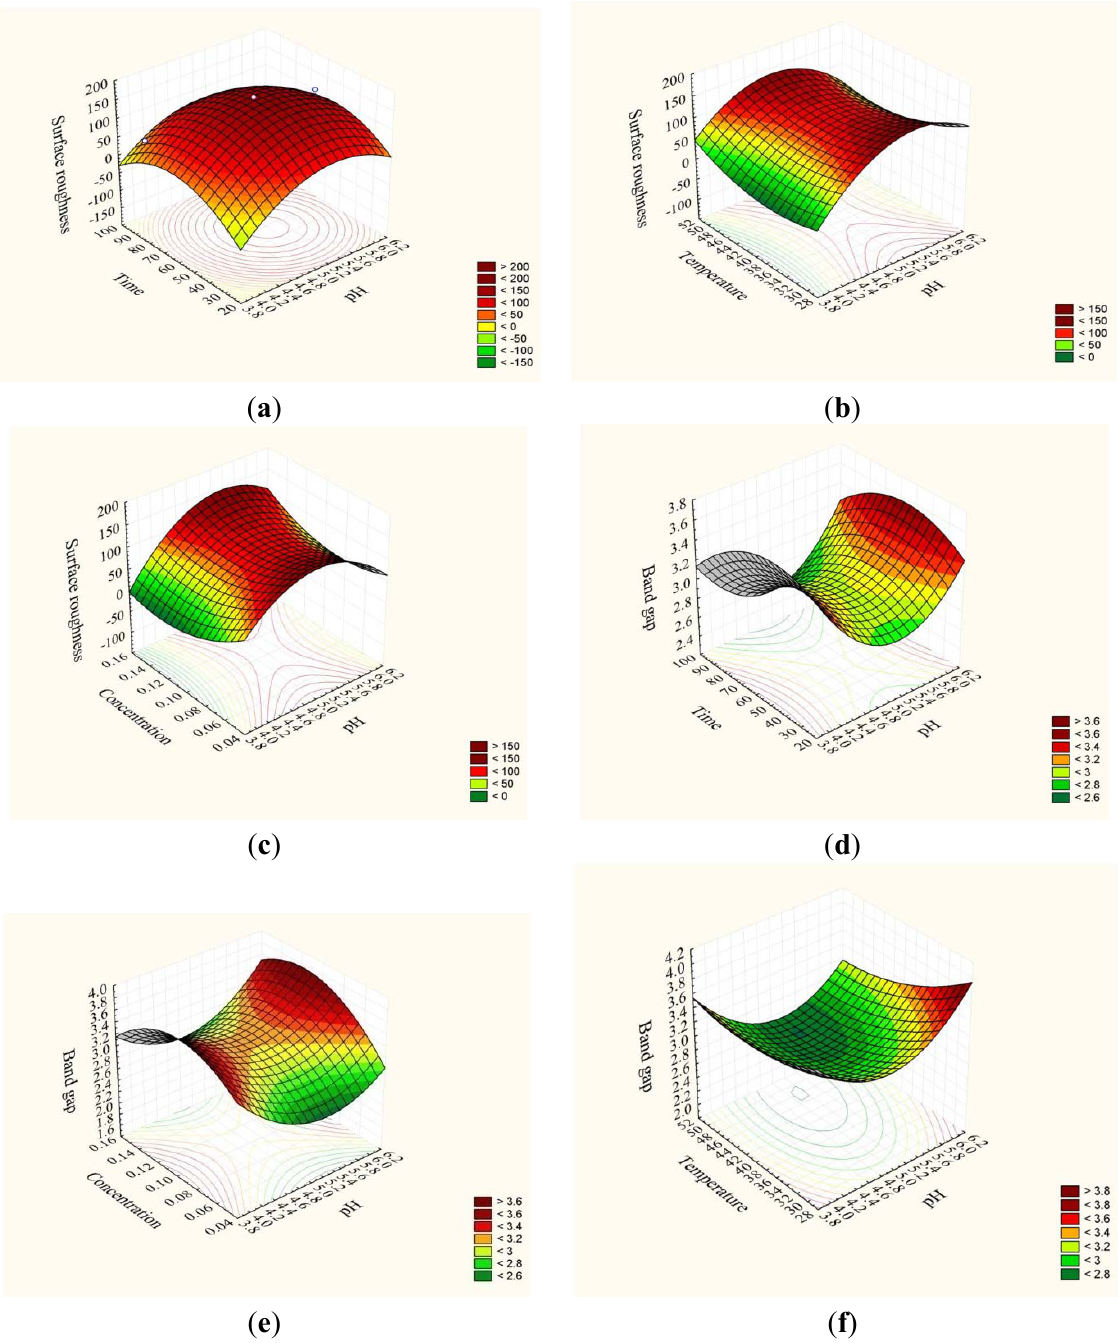
Figure 5. Response surface plots indicating the effect of interaction between process variables on synthesis of nanocrystalline SnO thin film ( a ) Interaction between time and 2 ( b ) Interaction between pH and concentration ( c ) Interaction between temperature and pH for surface roughness ( d ) Interaction between time and pH and ( e ) Interaction between pH and concentration ( c ) Interaction between temperature and pH for energy band